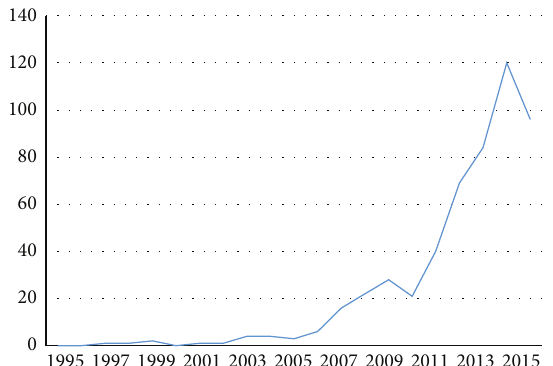
Figure 1: Publications per year reported in citation indexing service Scopus [23] when searching for the term lower limb exoskeleton.